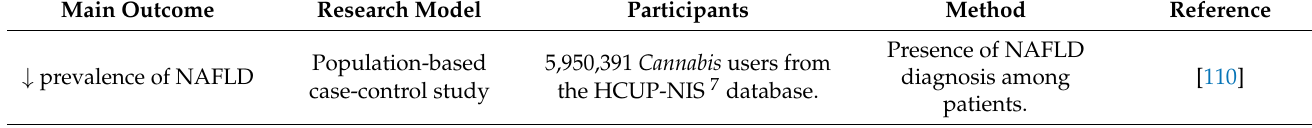
Table 2. Clinical studies analyzing the effects of Cannabis use on Non-alcoholic fatty liver disease (NAFLD) progression and